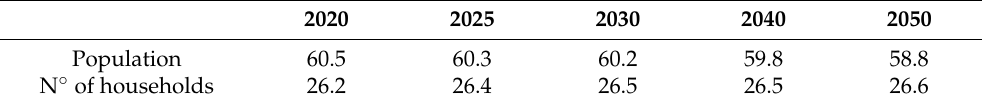
Table 1. Evolution of Italian demographic drivers, millions of inhabitants.